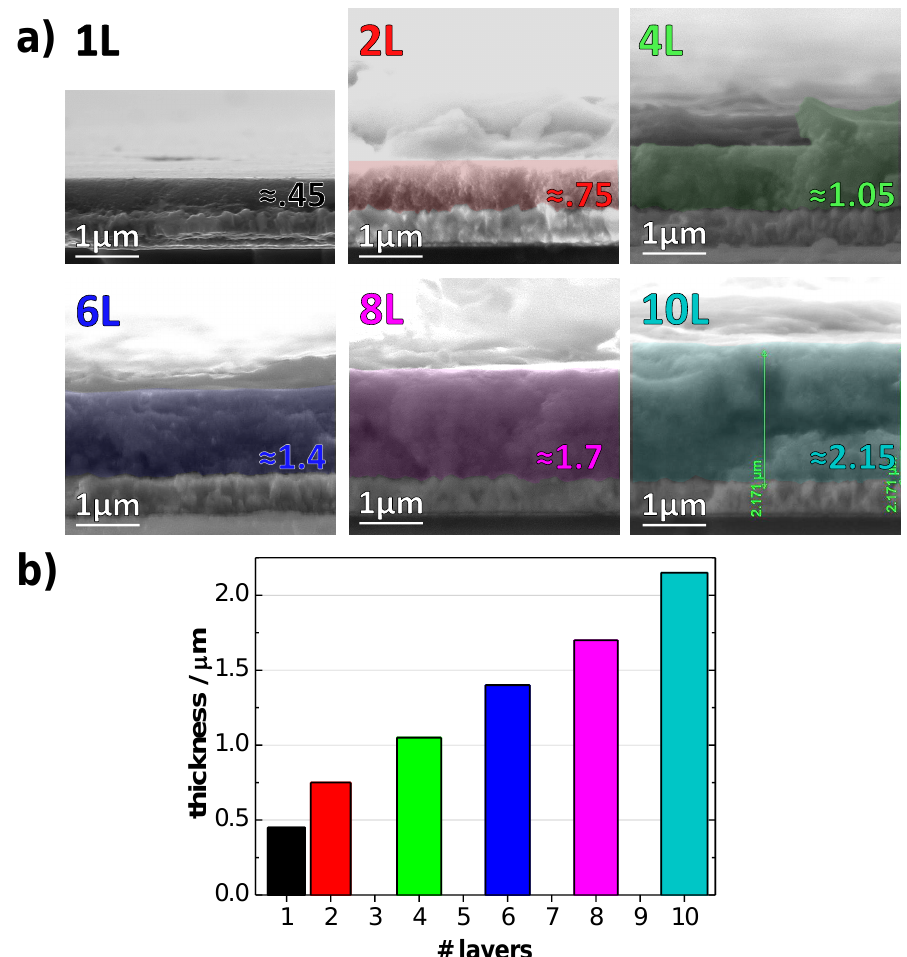
Figure 7. Development of film thickness as function of deposited MTTF layers. ( a ) Breaking edge SEM images of multi-layered MTTFs calcined at 550 ◦ C and ( b ) their corresponding thickness-versus-layer